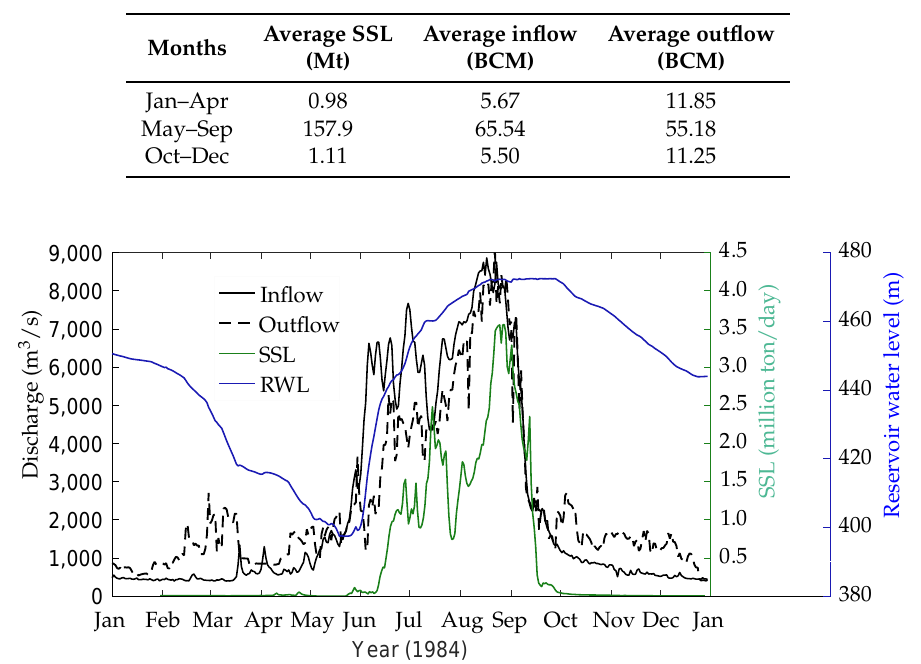
Table 3. Suspended sediment load and flow volume distribution in million tons (Mt) and billion cubic meters (BCM) from 1984–1990. Outflow also includes the minor contribution (0.04% and 0.16%) of the Siran and Brandu tributaries.